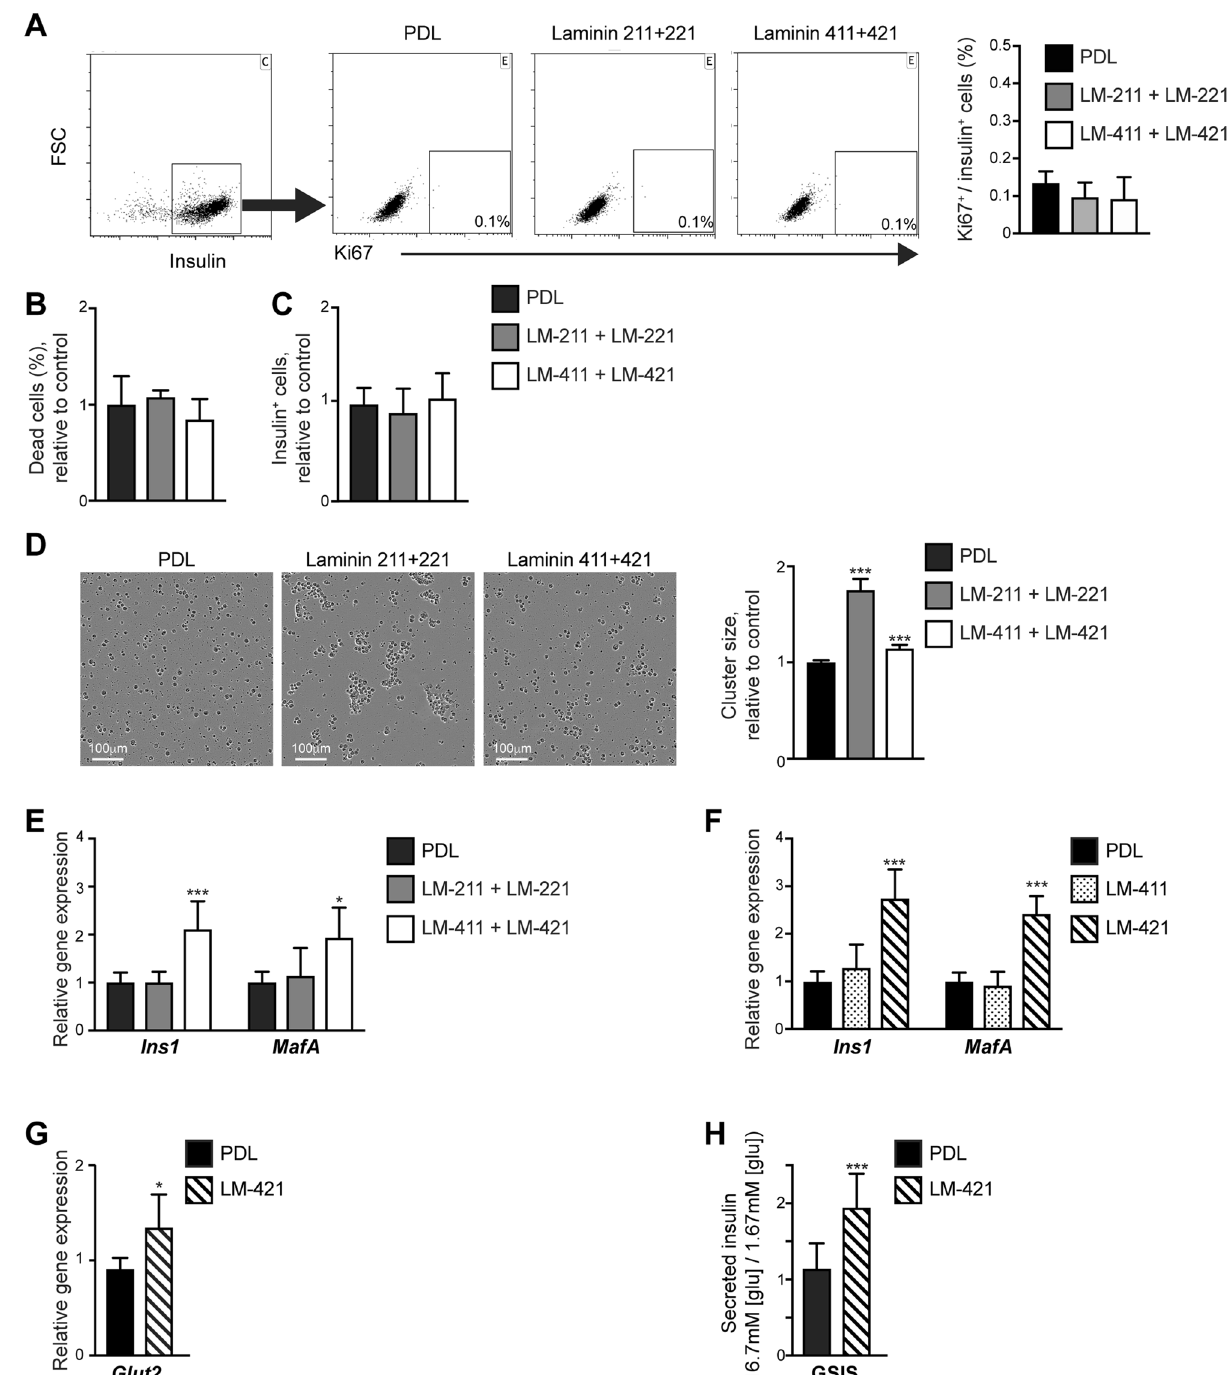
Figure 3. Pericytic laminins influence islet cells clustering, gene expression, and function. Dispersed mouse islet cells were cultured on either Poly-D-Lysine (PDL) or indicated recombinant laminin combinations (LM): LM-211 and -221 mixture (gray bars); LM-411 and -421 mixture (empty bars); LM-411 (dotted bars); or LM-421 (striped bars). ( A ) After cultured for 48 h, cells were stained for insulin and the proliferating cell marker Ki67 and analyzed by flow cytometry. Left , a representative dot plot of insulin staining. Middle , representative dot plots of Ki67 labeling of insulin + cells under each culture condition. Right , a bar diagram (mean ± SD) shows the percentage of Ki67 + cells of insulin + cells. n = 4. ( B ) Bar diagram (mean ± SD) shows the relative percentage of dead cells upon culturing on PDL (the average was set to ’1’) or laminins. Dead cells were identified as DAPI + unfixed cells. n = 3–4. C, Bar diagram (mean ± SD) shows the relative number of insulin-expressing cells upon culturing on PDL (the average was set to ‘1’) and laminins. n = 5. ( D ) Clustering of dispersed islet cells for 72 h. Left , representative images. Right , bar diagram (± SEM) shows the relative cluster size. n > 600 clusters for each condition. ( E – G ) Bar diagram shows a qPCR analysis of indicated genes upon culturing for 72 h. The averages of PDL-cultured cells were set to ’1’. n = 4–5. ( H ) Bar diagram shows glucose-stimulated insulin secretion (GSIS) analysis. After a 72-h culture on either PDL or LM-421, cells were incubated with low (1.67 mM) glucose concentration, followed by incubation with high (16.7 mM) glucose concentration. The levels of secreted insulin were measured, and the ratio between levels secreted in response to high and low glucose levels was determined for each well. n = 6–7. *, p < 0.05; ***, p < 0.005, as compared to PDL-treated